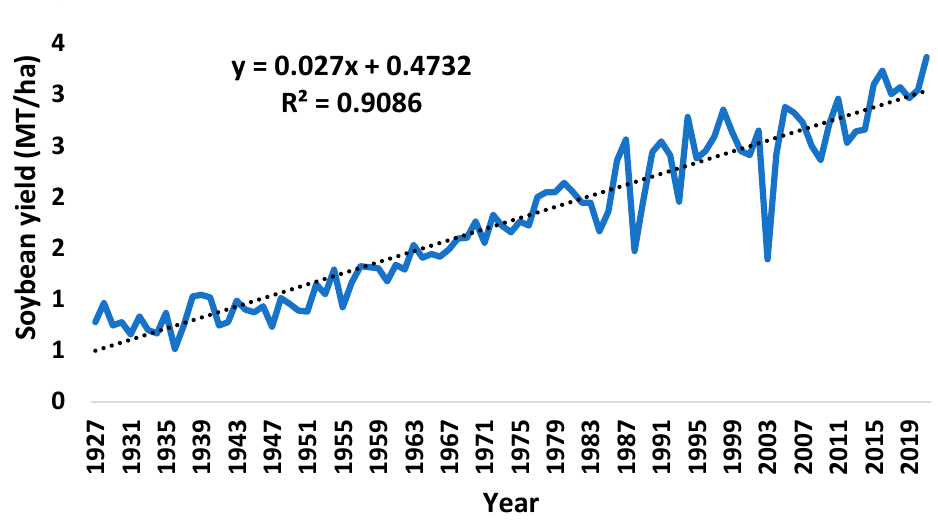
Figure 8. Long ‐ term trend in historical soybean yields for Buchanan County, Iowa. Figure 8. Long-term trend in historical soybean yields for Buchanan County,